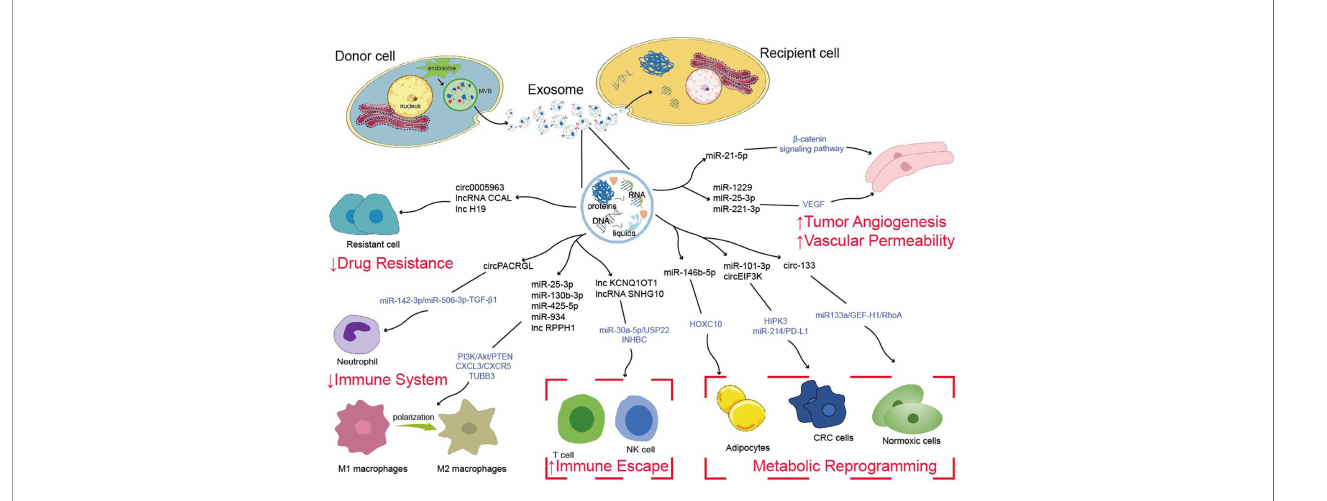
FIGURE 2 | Possible mechanisms of exosome-derived ncRNAs to regulate tumor metastasis, tumor immunity, tumor metabolism and drug